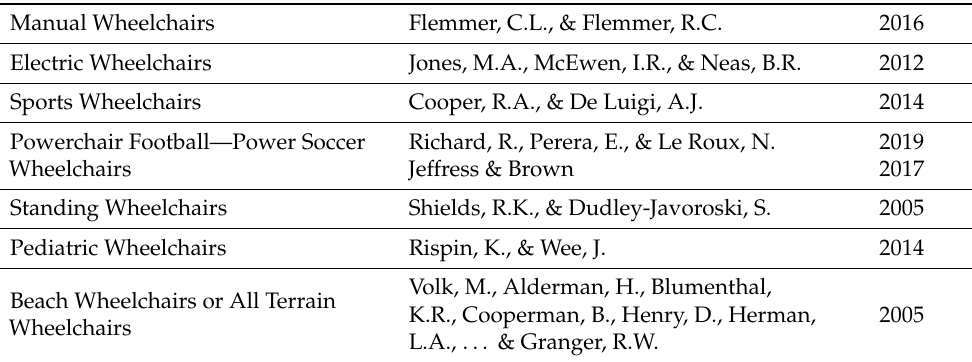
Table 2. Types of wheelchairs reviewed in the published literature.